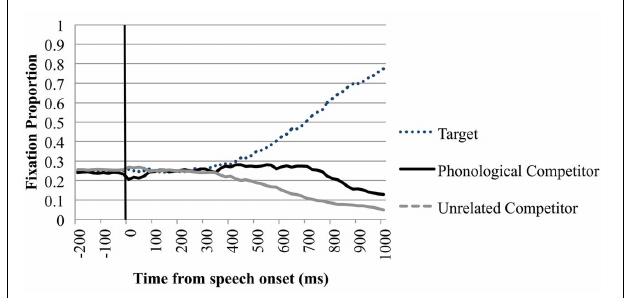
FIGURE 2 | Eye-movements in the phonological trials of the perception condition. Proportion of fixations are sorted per quadrant and plotted as a function of time. Time point − 200 is the onset of the display. Speech onset of the target word is at 0ms, as indicated by the black line.